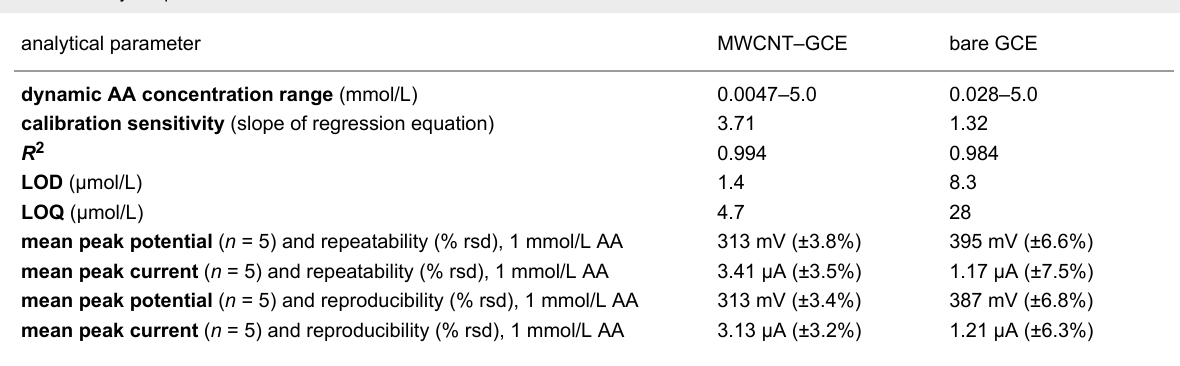
Table 1: Analytical performance of the SWV